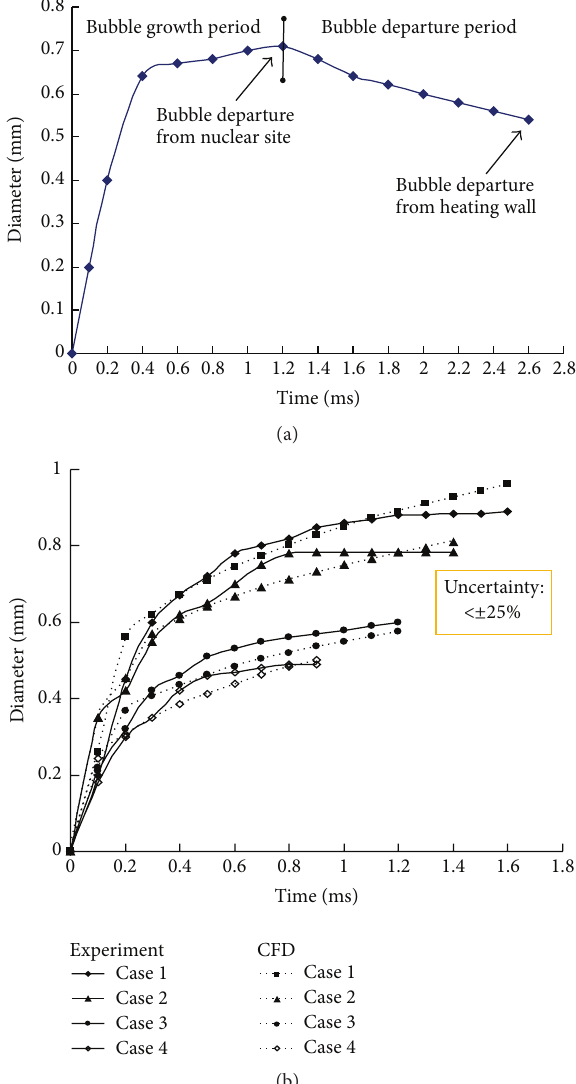
Figure5:(a)Thebubblediameterinbubblegrowthanddetachment process on case 1 . (b) Comparison between simulation and experi- mental results of bubble grow